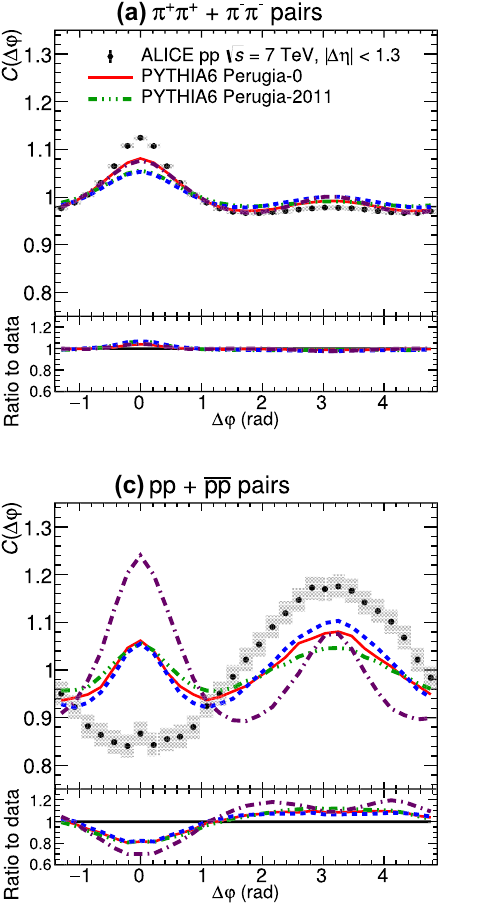
Fig. 6 (cid:3)η integrated projections of correlation functions for com- bined pairs of a π + π + + π − π − , b K + K + + K − K − , c pp + pp and d (cid:5)(cid:5) + (cid:5)(cid:5) , obtained from ALICE data and four Monte Carlo mod-